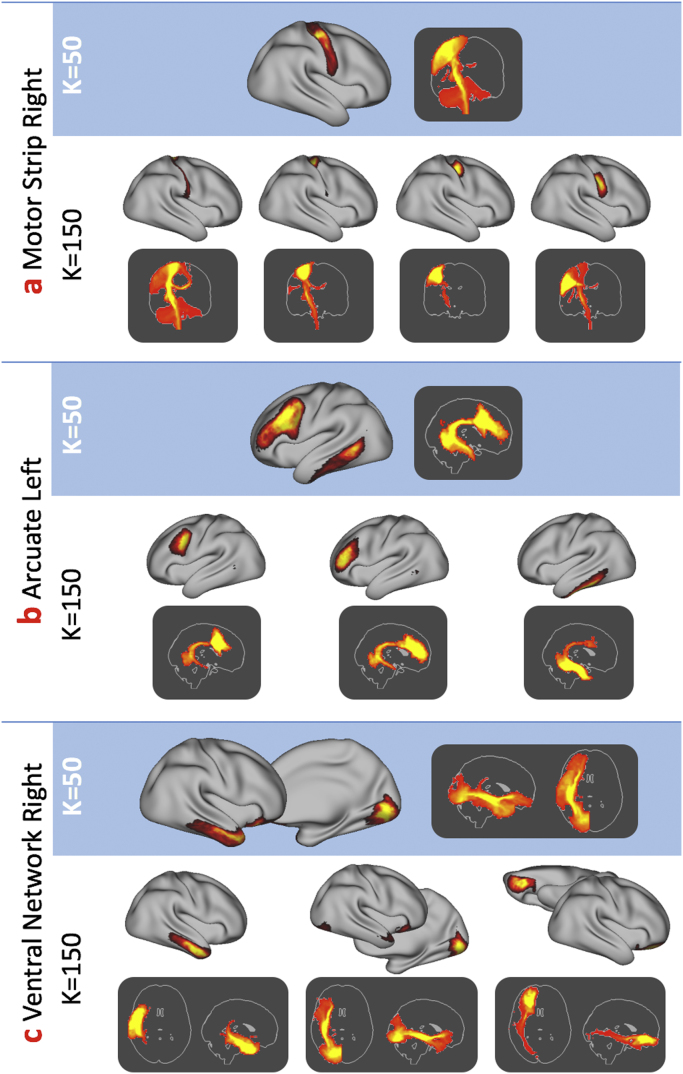
Illustration of the effect of ICA dimensionality selection on resulting components, here comparing components identified in a K=50 ICA with their most similar (highest spatial correlation) equivalent components in the K=150 ICA. In three examples, (a) the motor strip gets split into four neighbouring subregions, (b) grey matter associated with the arcuate into three subregions with slightly different spatial trajectories of structural connectivity and (c) a ventral and lateral network (not associated with any single specific fibre bundle) gets split into three more anatomically distinct and identifiable regions.